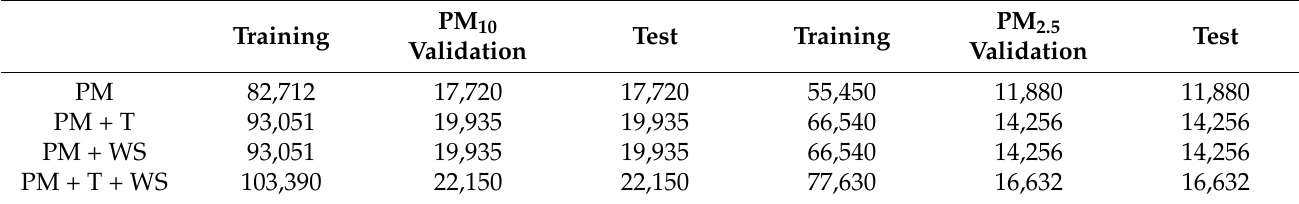
PM + T + WS Table 4. Number of neurons in each layer of the models for PM 10 and PM 2.5 and the four different input cases.